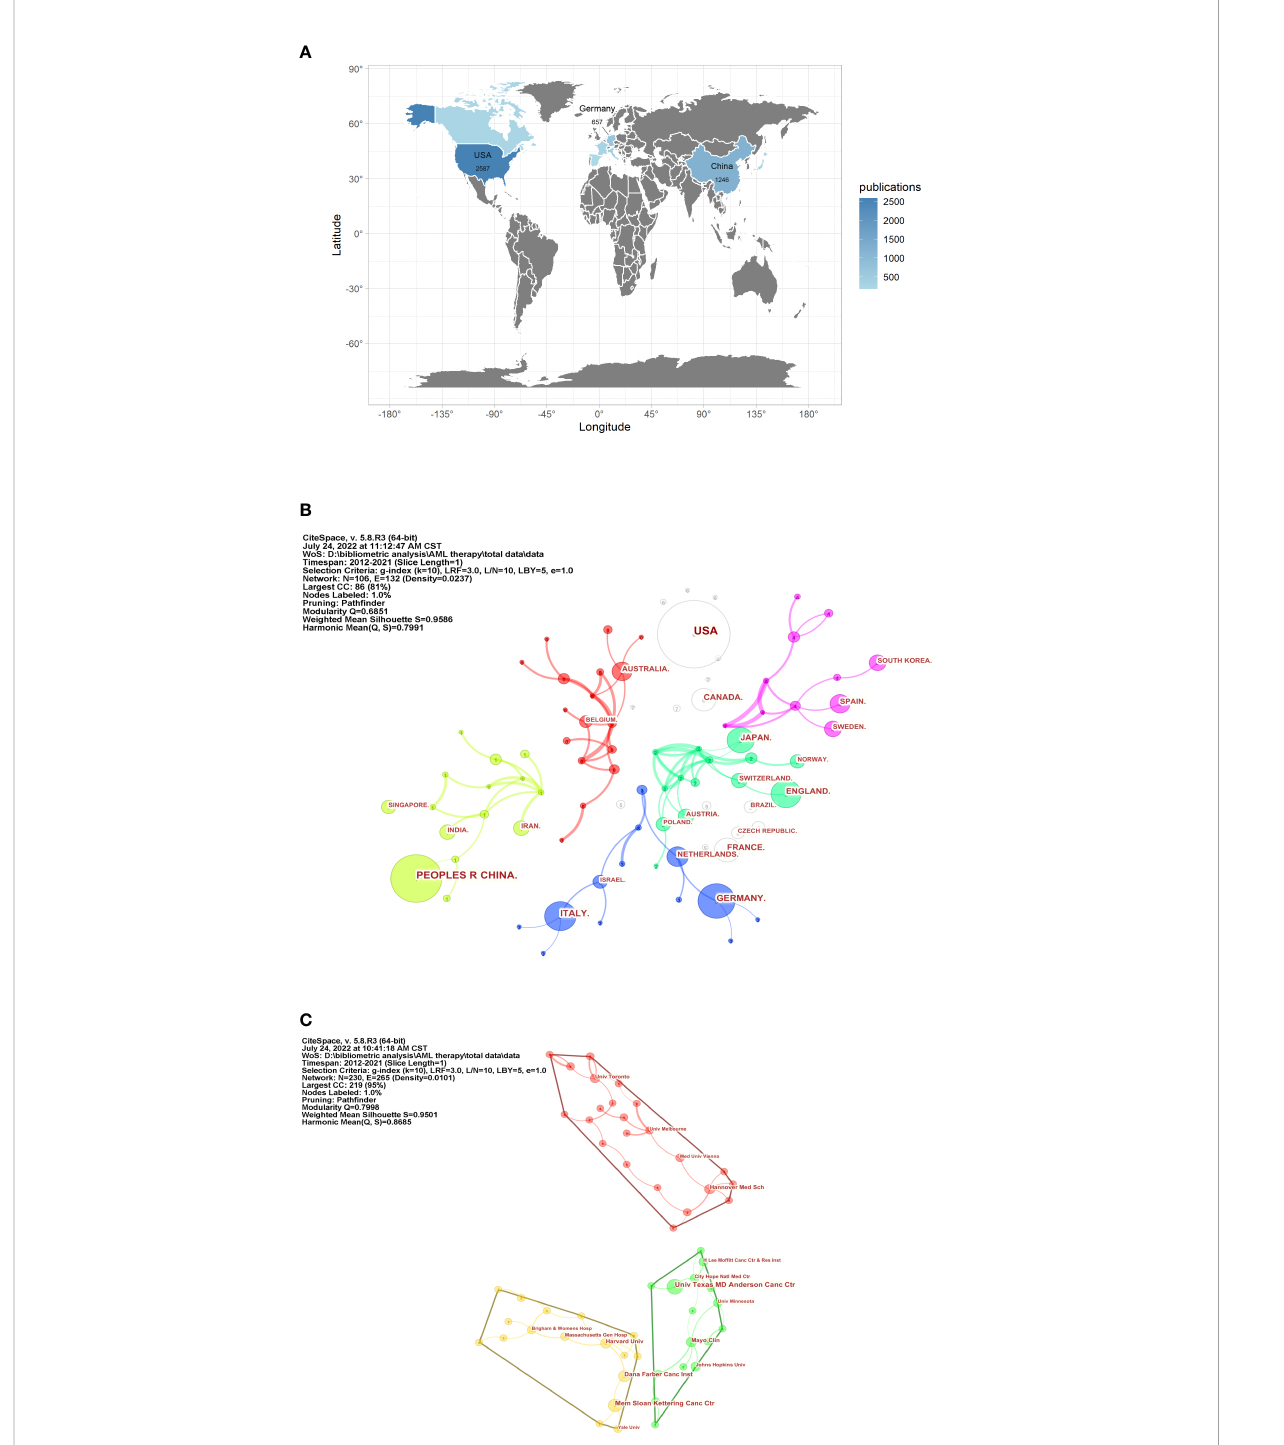
FIGURE 2 Country and institution analysis of targeted therapy in AML. (A) Top 10 countries for publications on the world map. (B) The network of countries for co-authored articles on targeted therapy in AML. Nodes represent publications from countries. The more frequently the publications of countries are cited, the larger is the size of the node. Links between nodes describe a co-occurrence or a co-citation between these nodes, and their thickness indicates the strength of these correlations: the thicker the line, the closer is the connection between them. The node color and link color indicate different clusters; the nodes that are of the same color belong to the same closely related cluster. (C) The network of